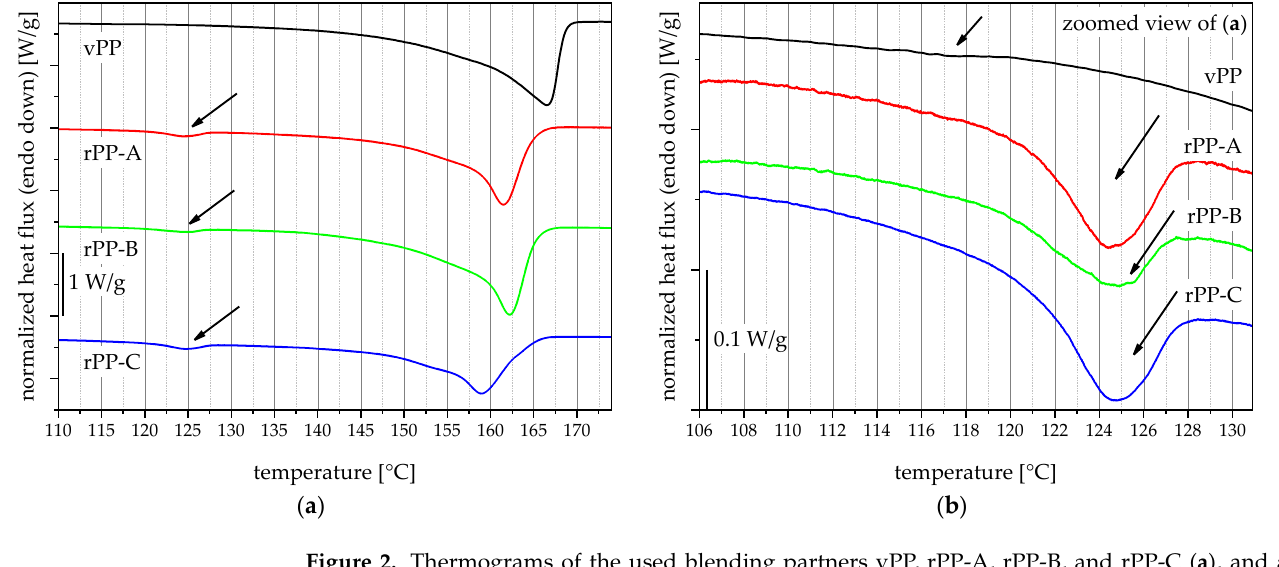
Figure 2. Thermograms of the used blending partners vPP, rPP-A, rPP-B, and rPP-C ( a ), and a detailed view of the polyethylene (PE) melting peaks in the same materials ( b ).